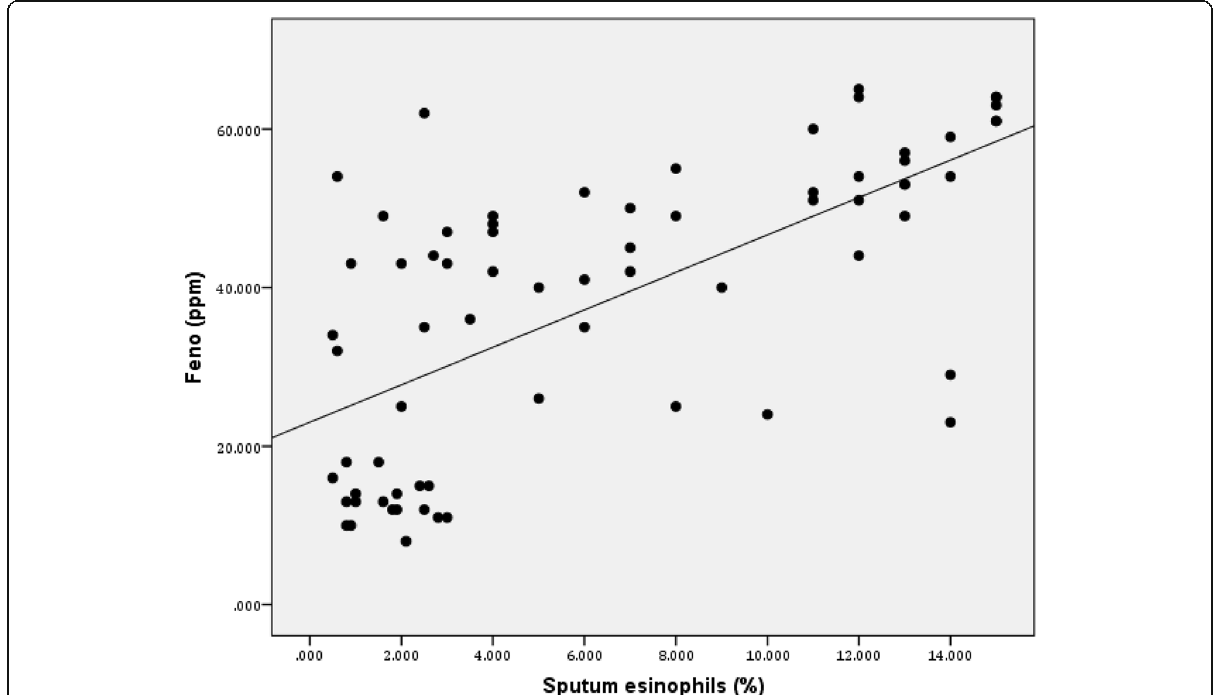
Fig. 1 Scatter dot graph showing significant positive correlation between Feno and sputum eosinophil